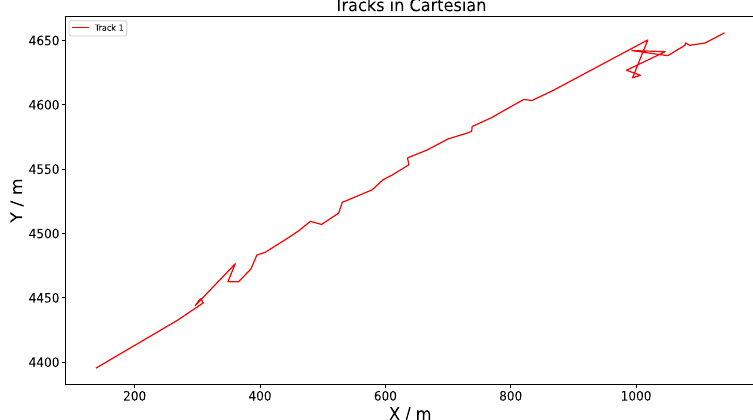
Figure 12. Single-target track in the Cartesian coordinate system (REMTT).